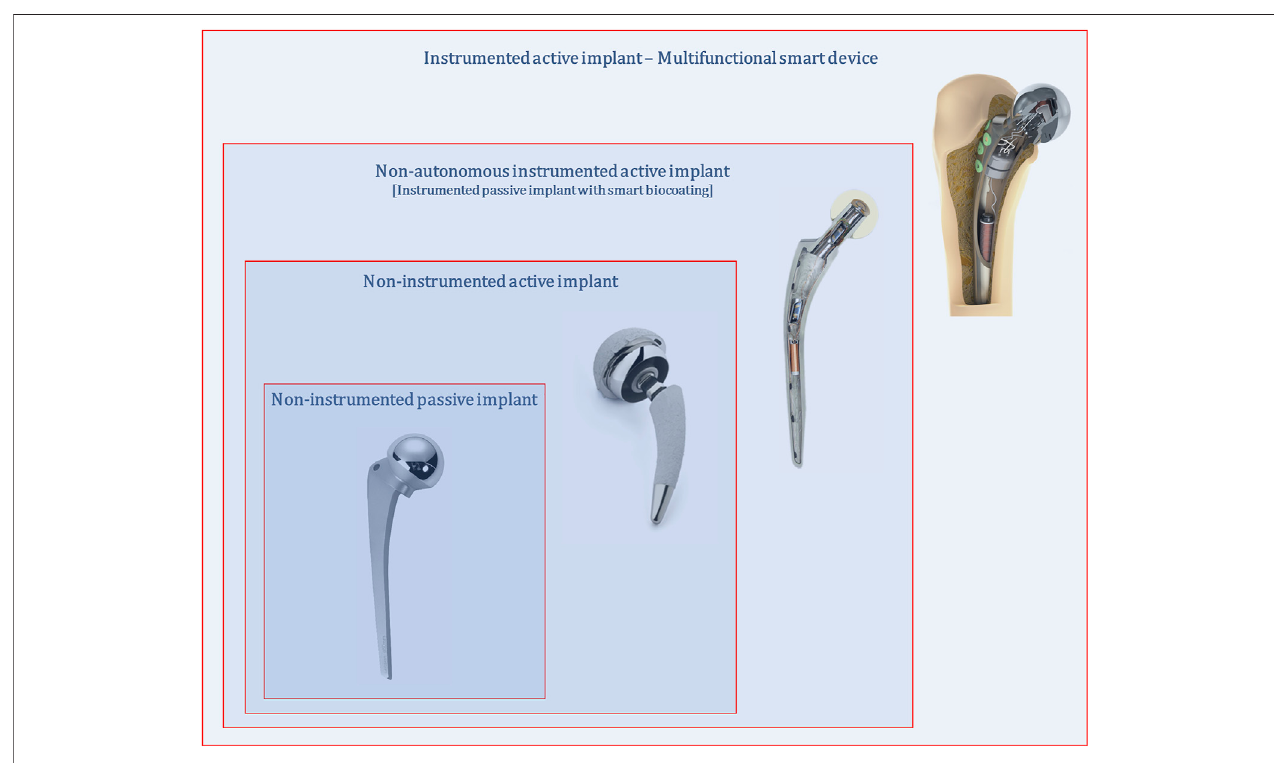
FIGURE 2 | Multifunctional smart implants as hybrid technologies framing non-instrumented passive, non-instrumented active and instrumented passive implant technologies.